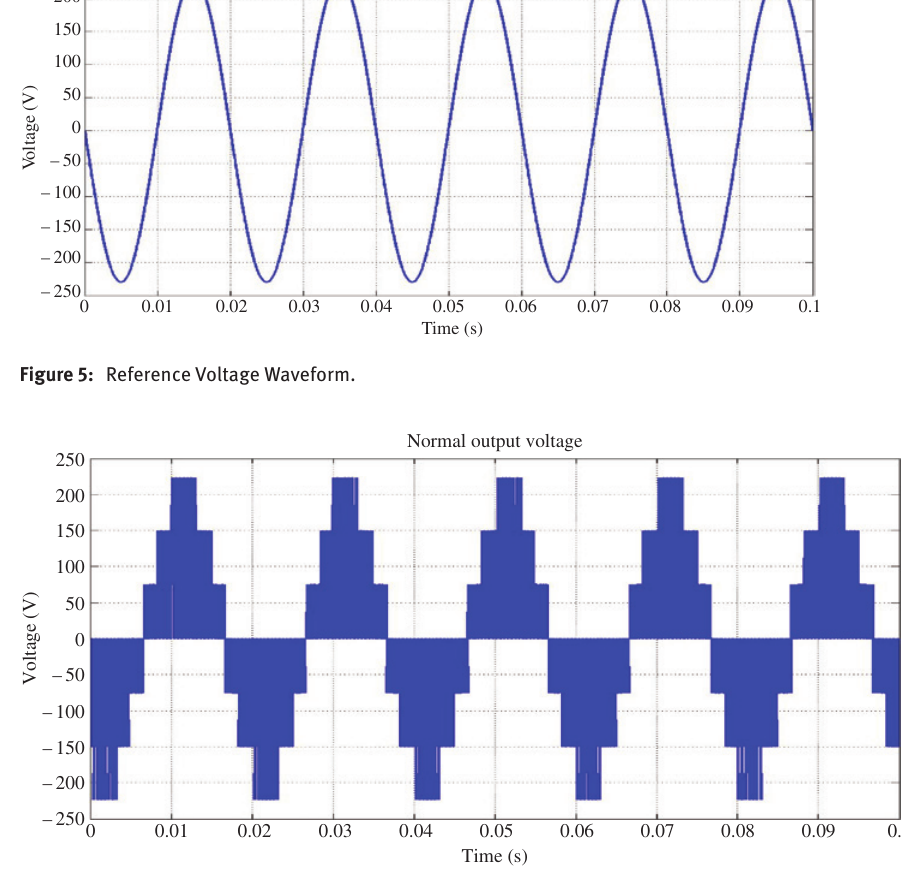
Figure 6: Seven-Level Inverter Output Voltage without Controller.